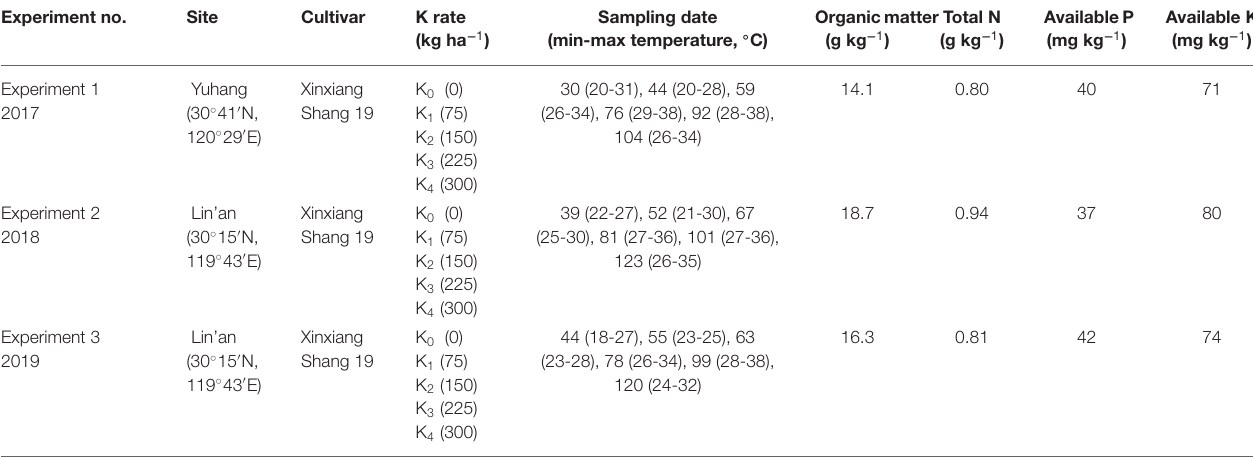
TABLE 1 | Nutrient content data for the three field experiments. Experiment